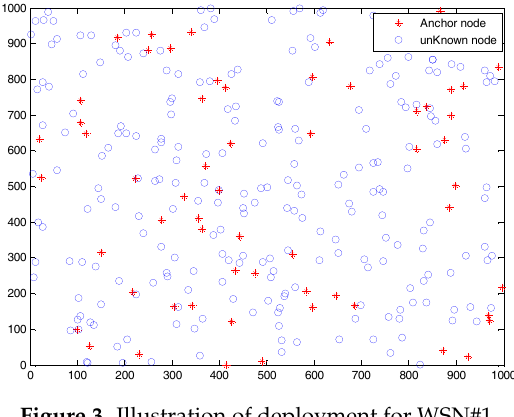
Figure 3. Illustration of deployment for WSN#1 .